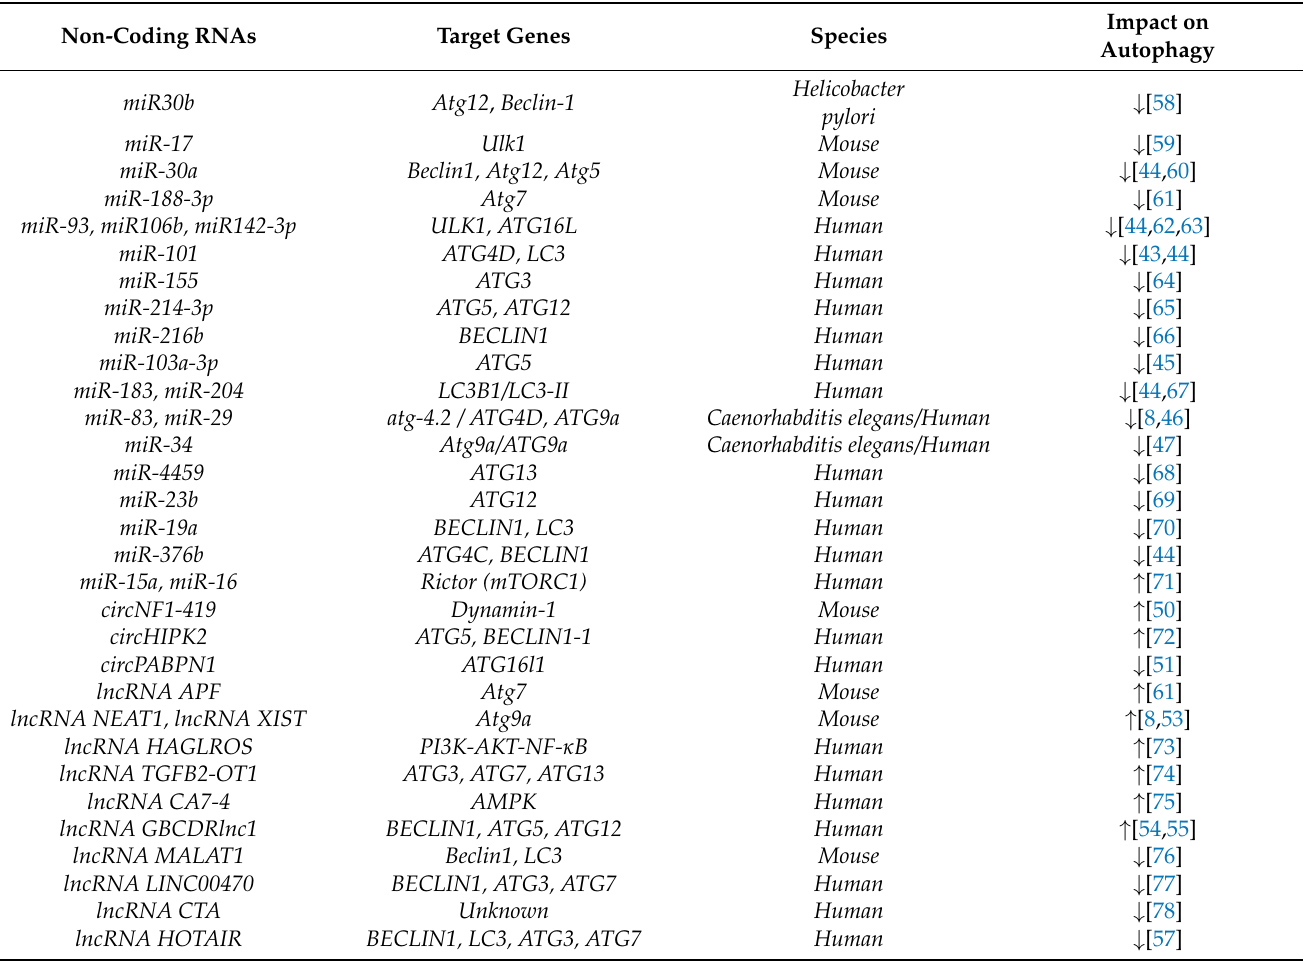
Table 2. Non-coding RNAs involved in autophagy. Non-Coding